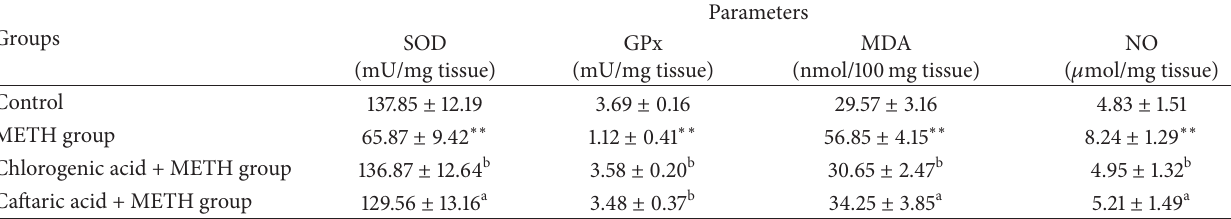
Table 5: Effect of chlorogenic and caftaric acids on liver SOD, GPx, MDA, and NO of METH-injected rats.